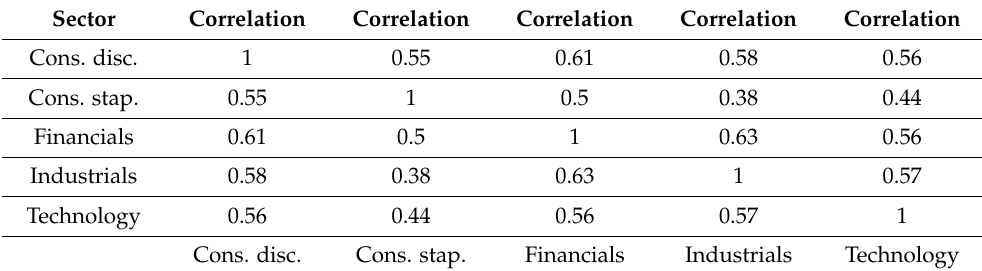
Figure 3. Daily Sentiment for each sector.